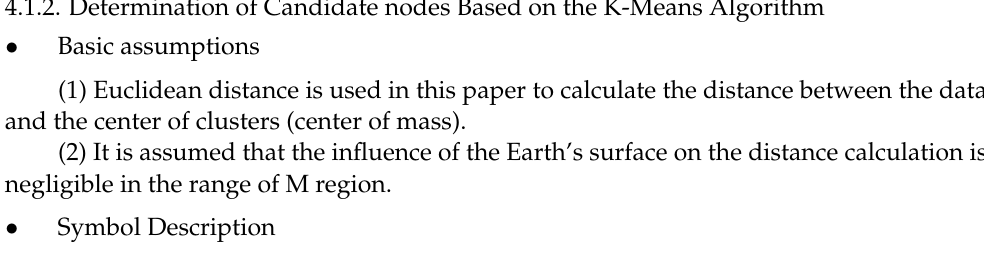
Figure 5. Schematic diagram of express packaging reverse logistics network hierarchy and nodes in M region .